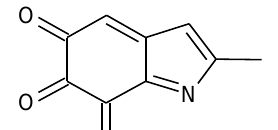
Figure 13. A three-electron oxidized building block, which would be needed for the generation of closed-shell tautomers at oxidation levels above KP-8e.